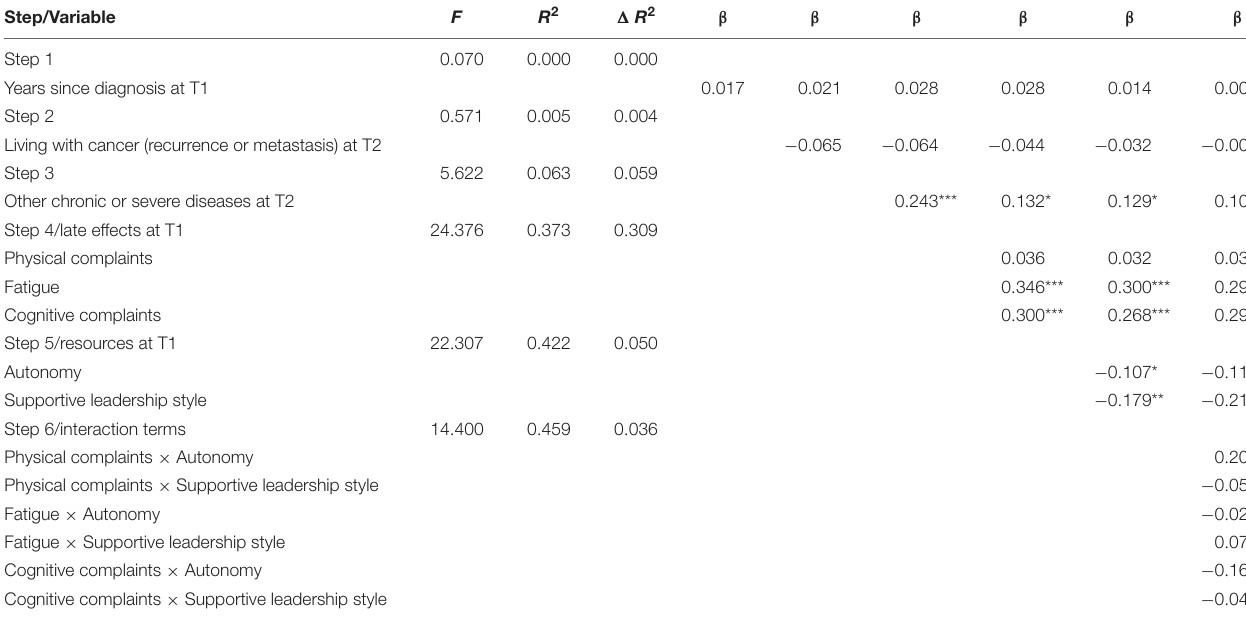
TABLE 3A | Multivariate regression analyses for moderation by autonomy or supportive leadership style (at T1) of the association of physical complaints, fatigue, or cognitive complaints (at T1) with future burnout complaints (at T2), controlled by years since diagnosis, living with cancer (recurrence or metastasis) and other chronic or severe